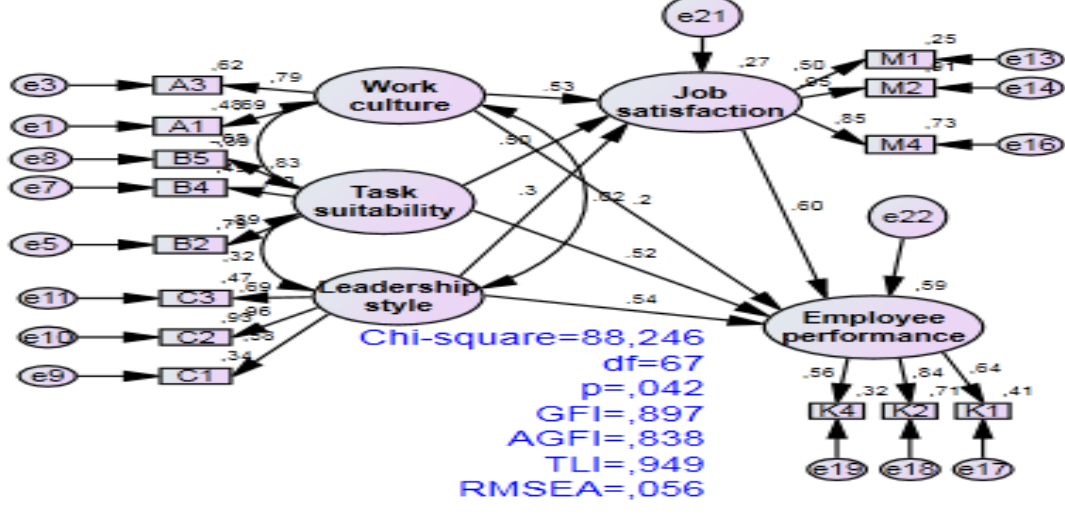
Figure 2 : Model Suitability Test Results (full model).